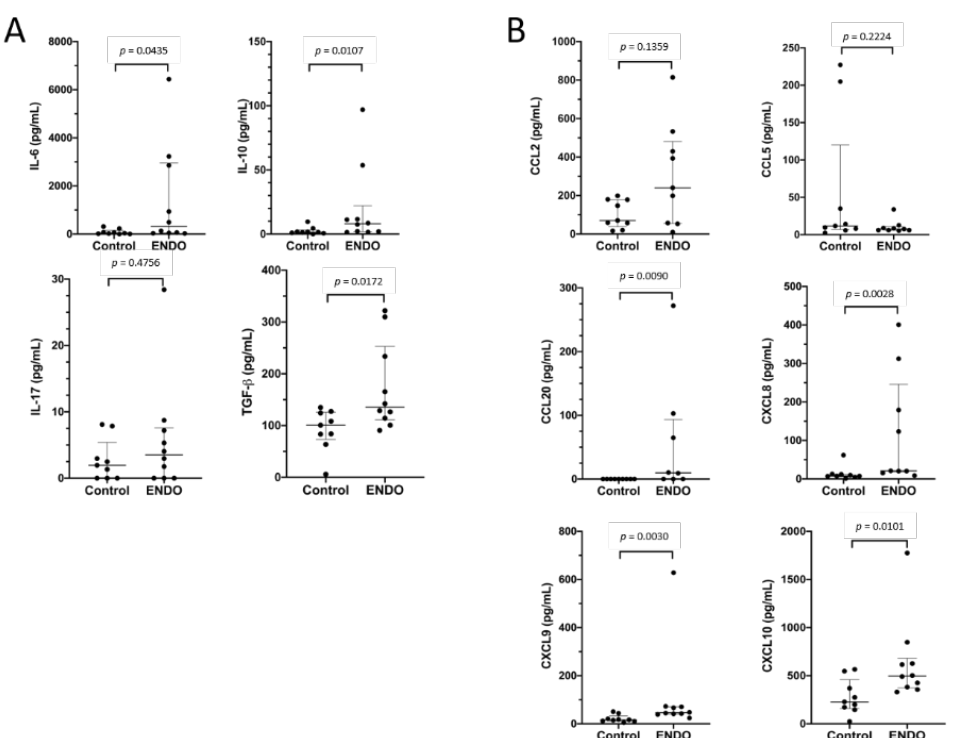
Figure 3. Concentrations of the immunoregulatory cytokines ( A ) and chemokines ( B ) related to generation and function as well as migration and activation of Treg and TH17 cells in the peritoneal fluid of control women (Control) and patients with endometriosis (ENDO). Peritoneal fluid concentrations of cytokines (IL-6, IL-10, IL-17A, and TGF- β 1/2) and chemokines (CCL2, CCL5, CCL20, CXCL8, CXCL9, and CXCL10) were evaluated as described in the Materials and Methods section. The results are shown as median and interquartile range. Statistical differences between groups were tested by two-tailed Mann–Whitney U -test.